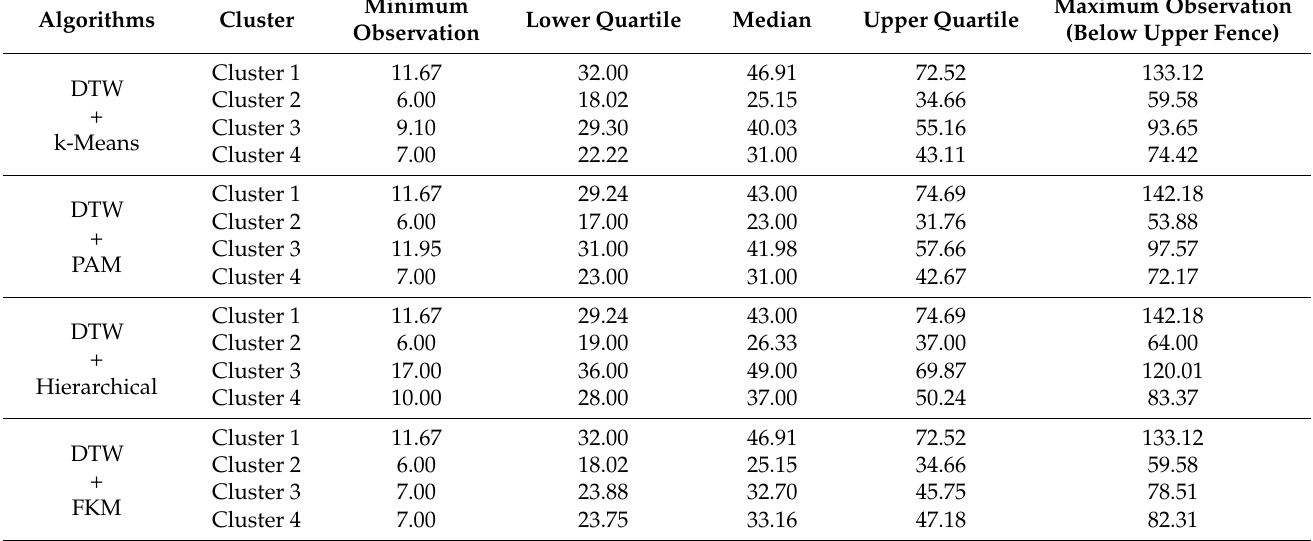
Table 4. Minimum, lower quartile, median, upper quartile and maximum (below upper fence) observations of PM 10 according to clusters based on four clustering algorithms for daily maximum data extracted from the corresponding